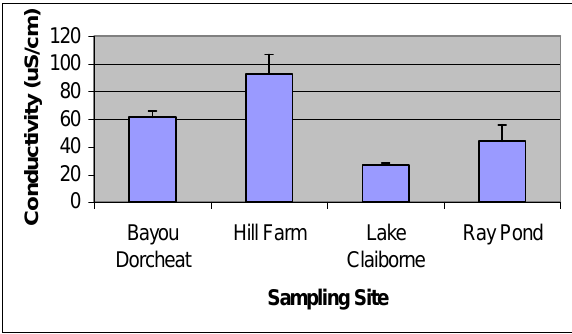
Figure 7: Mean values of conductivity ( μ S/cm) at each sampling site. Differences in mean values among the sampling sites are highly significant (p<0.0001).